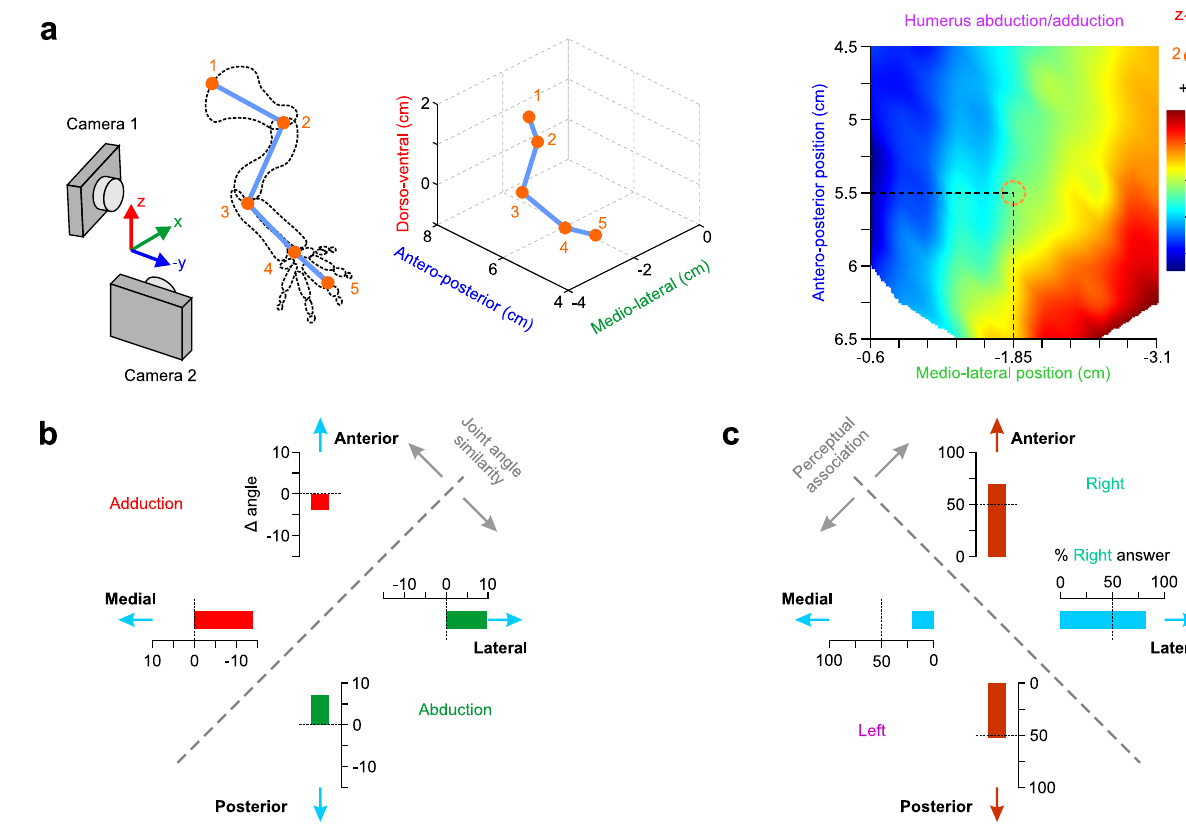
Fig. 4 | Perceptual discrimination is not based on changes in joint angles. a Identi fi cation and tracking of mouse forelimb joints with stereo cameras (see Methods for details) yields the humerus abduction/adduction angle (color map, linearinterpolation)mappedontotheplanarworkspacede fi nedinSupplementary Fig. 1b (orange circle: manipulandum ’ s home position). b Changes ( Δ angle mea- sured from the map in a) in humerus adduction (negative values) or abduction